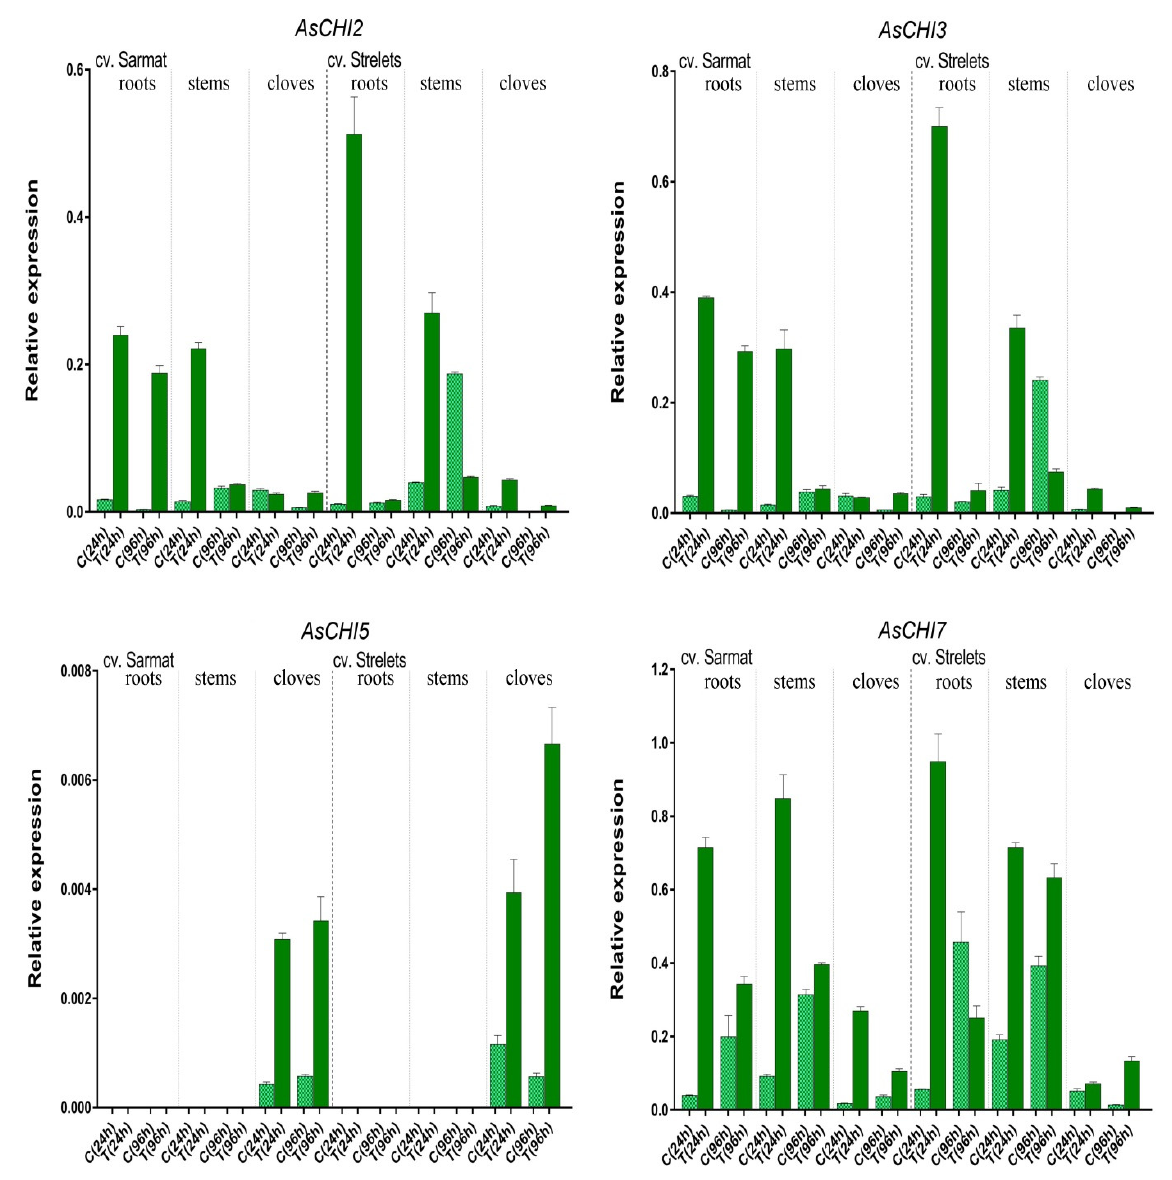
Figure 6. Expression of the AsCHI genes in roots, stems, and cloves of Allium sativum cv. Sarmat and Strelets: in control (C) and treated (T; after 24 and 96 h of Fusarium proliferatum infection) plants. The data were normalized to mRNA levels of GAPDH and UBQ genes and presented as the mean ± SE ( n = 3).